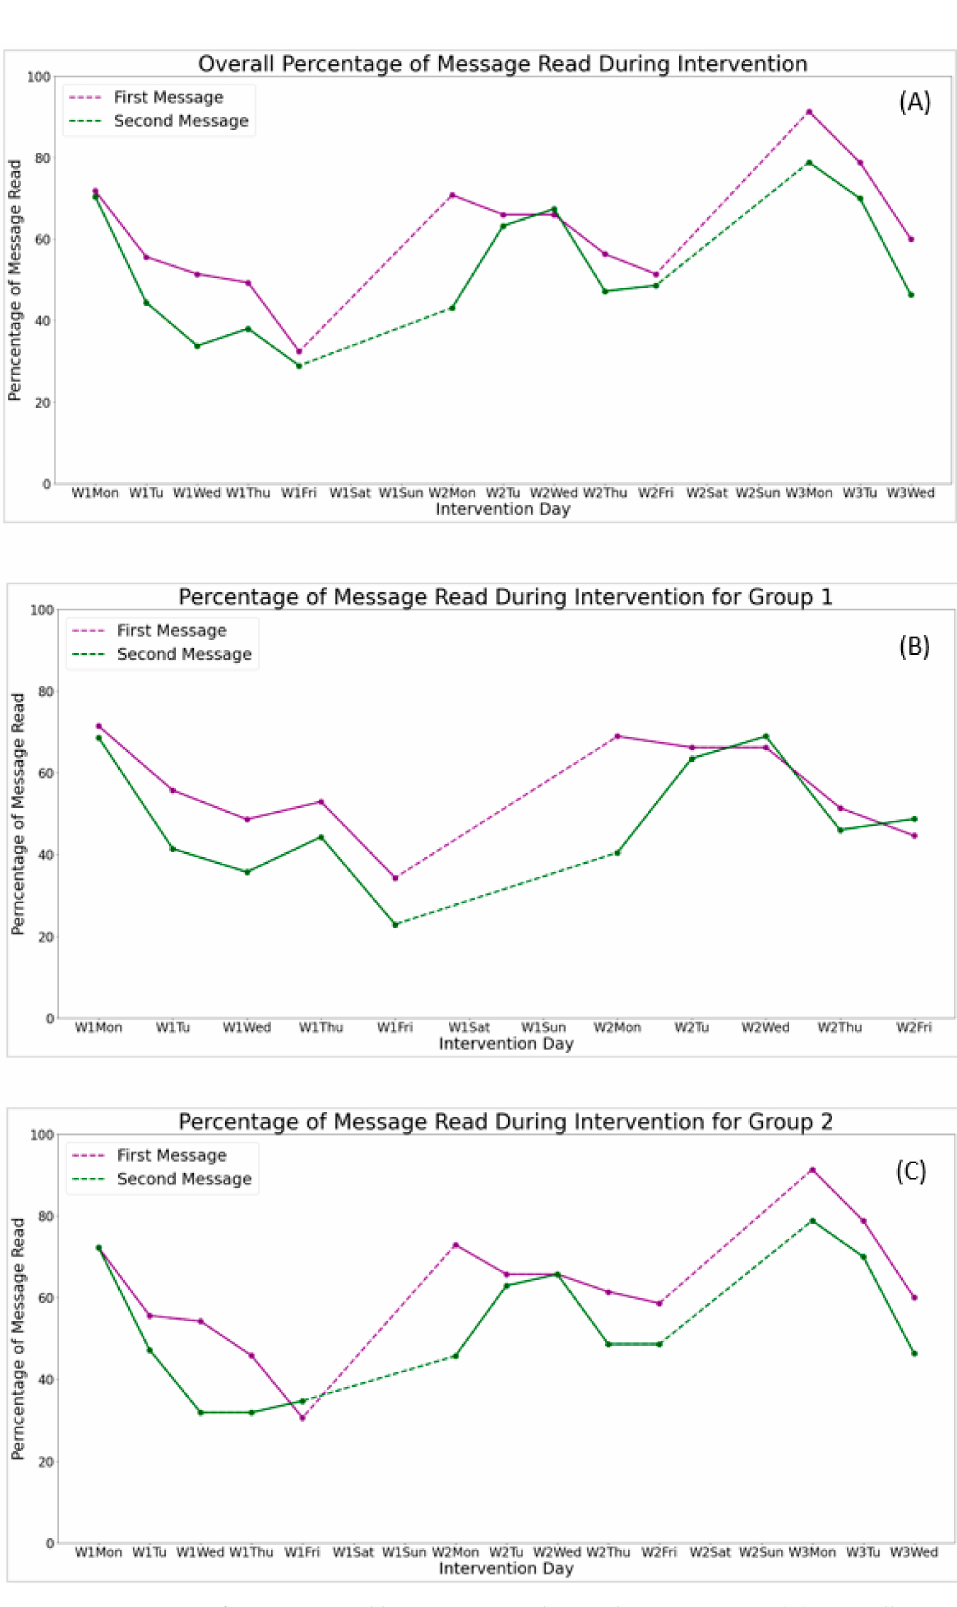
Figure 2. Percentage of messages read by participants during the intervention. ( A ): Overall percent- age of message read during intervention; ( B ): Percentage of message read during intervention for Group 1; ( C ): Percentage of message read during intervention for Group